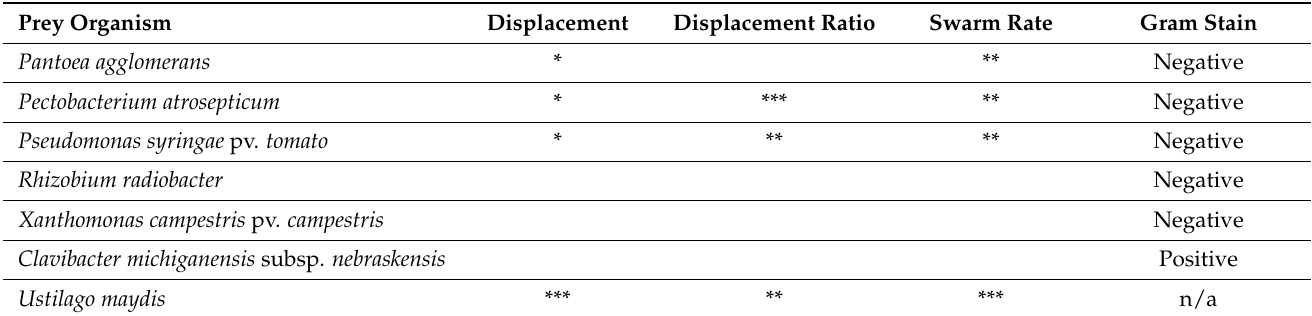
Table 3. Pairwise comparisons between dead and lysed cells for each prey and measurement metric. Asterisks indicate statistical significance between predatory behaviour on dead vs. lysed cells within